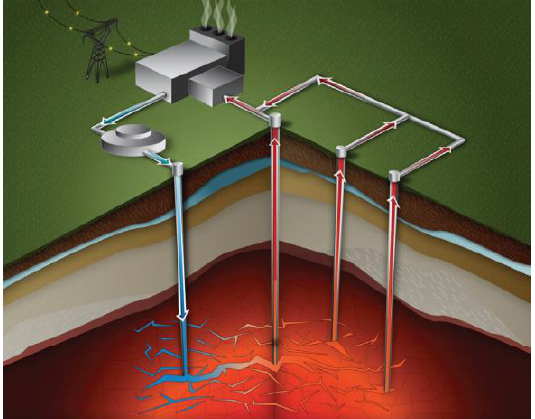
Figure 3. Enhanced Geothermal System concept [28].